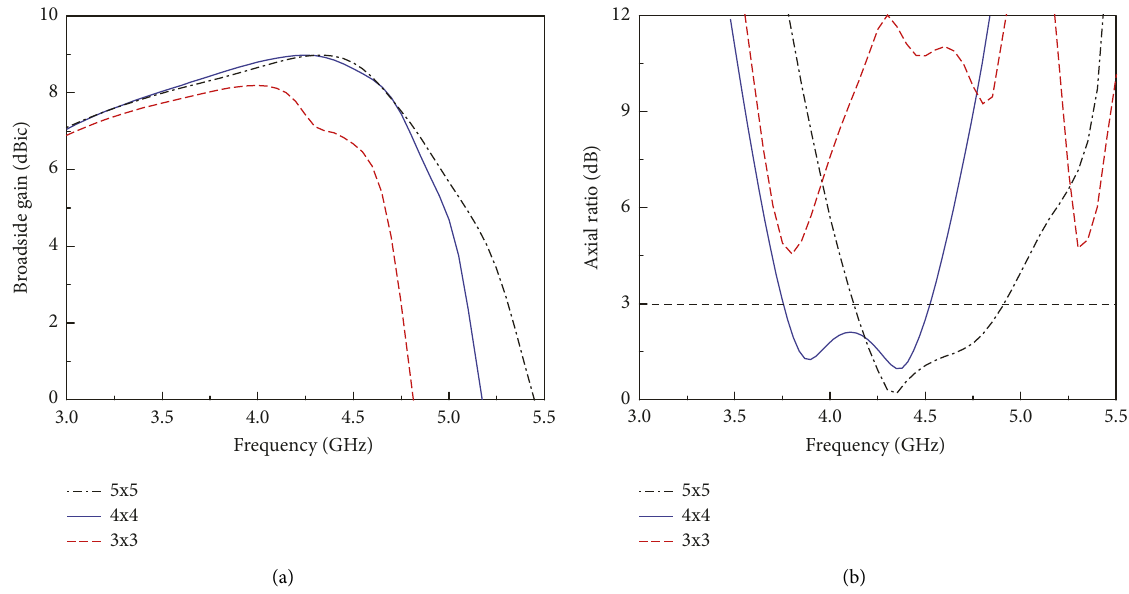
Figure 3: Characteristics of 3 × 3, 4 × 4, and 5 × 5 metasurfaces antennas: (a) gain and (b)